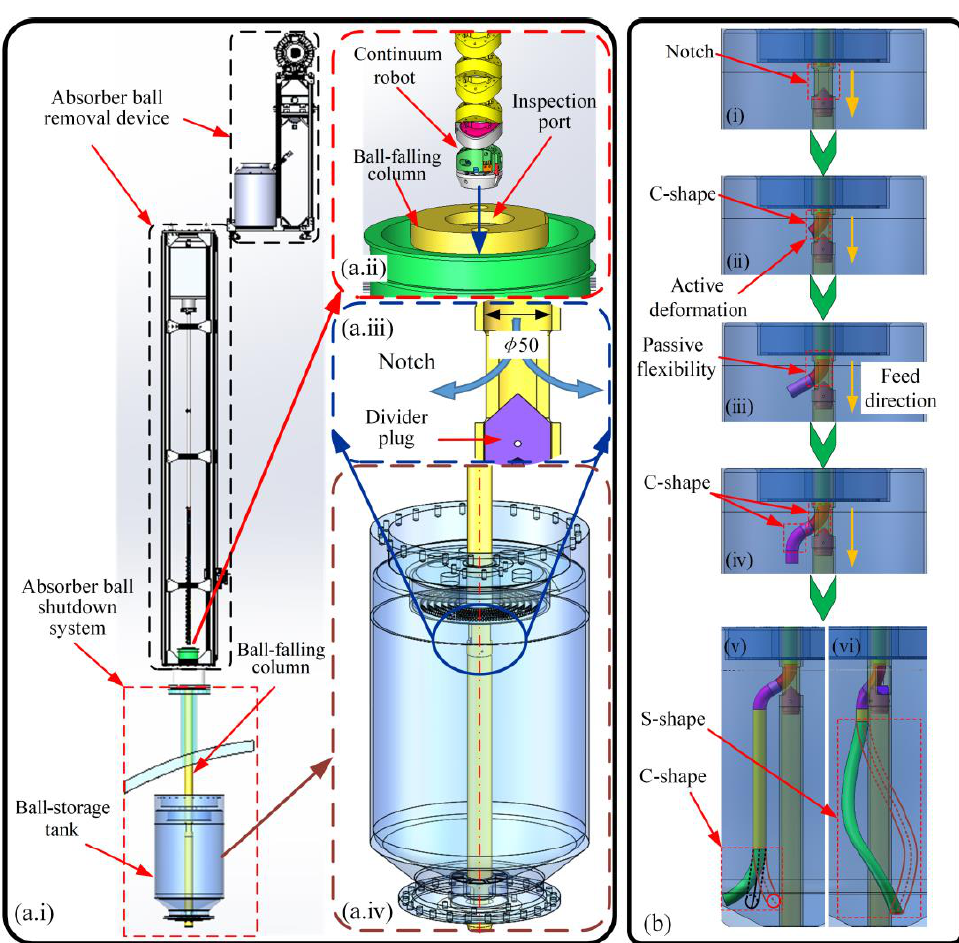
Figure 1. Working scene of the continuum robot. ( a . i ) Working scene. ( a . ii ) Inspection port. ( a . iii ) Divider plug and rectangular notch. ( a . iv ) Ball-storage tank. The continuum robot system is mounted on the reserved detachable interface and performs the removal operation. ( b ) Access (in/out) strategy. ( i ) The continuum robot enters at the inspection port and moves down to the divider plug. ( ii ) The end arm of the continuum robot actively bends at a certain angle towards the notch on one side of the divider plug and ( iii , iv ) continues to move downward, the residual arm of